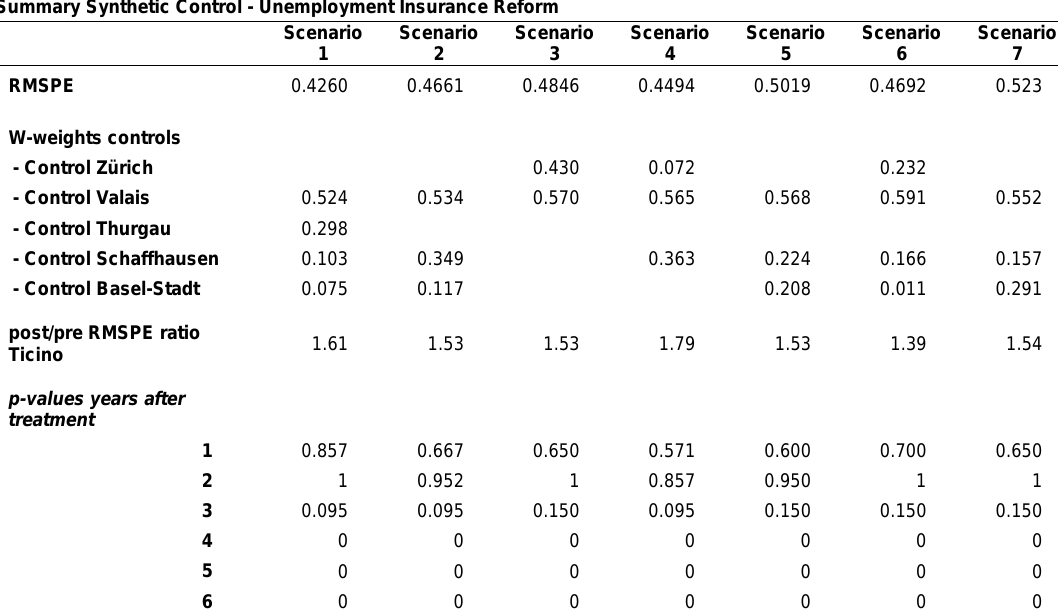
Table 2. Summary of the SC and placebo effects